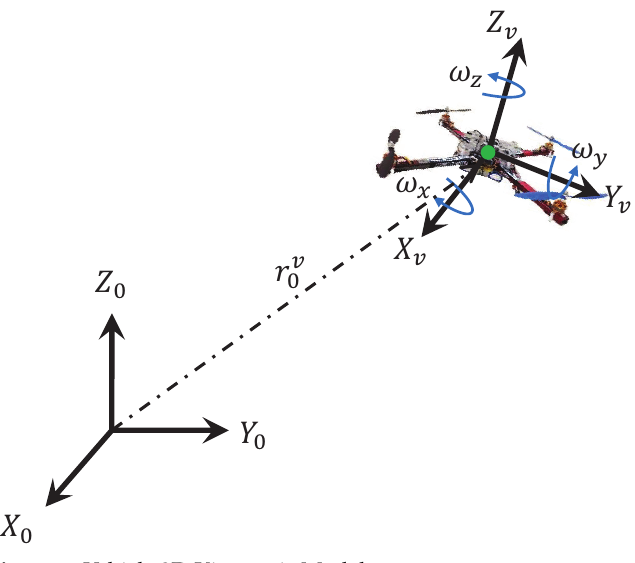
Figure 1. Vehicle 3D Kinematic